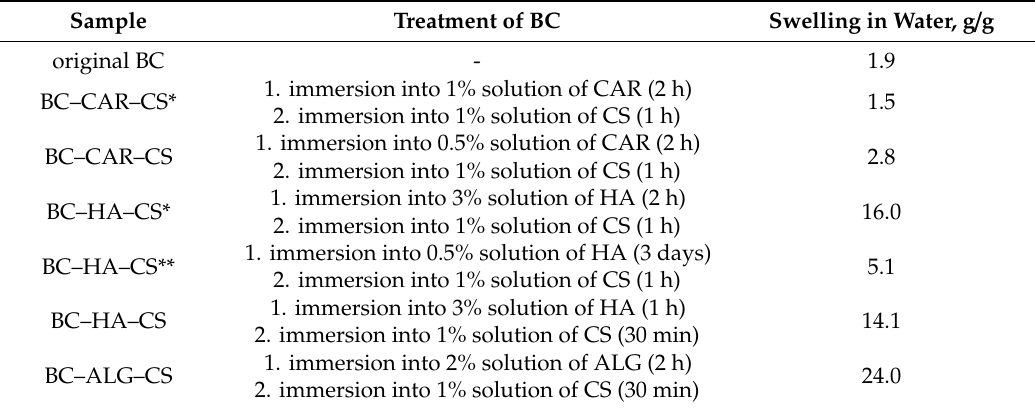
Table 1. Preparation and properties of bacterial cellulose composites. (For all samples): The final treatment of the samples was 2% ammonia in ethanol, washing with ethanol, and drying at room